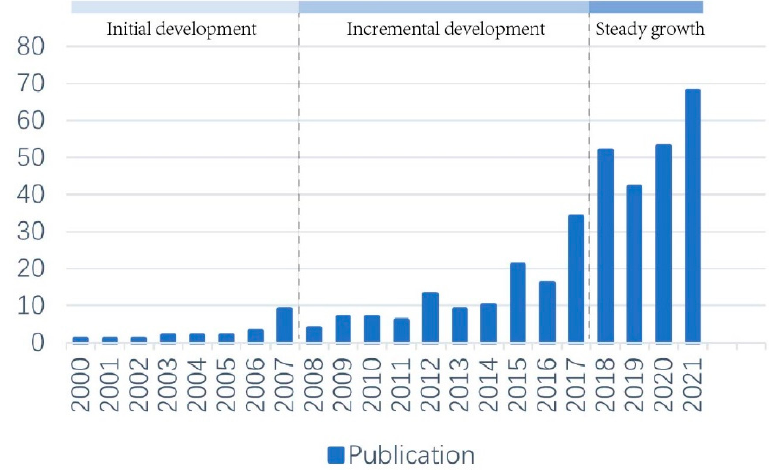
Figure 1. The number of publications from 2000 to 2021.